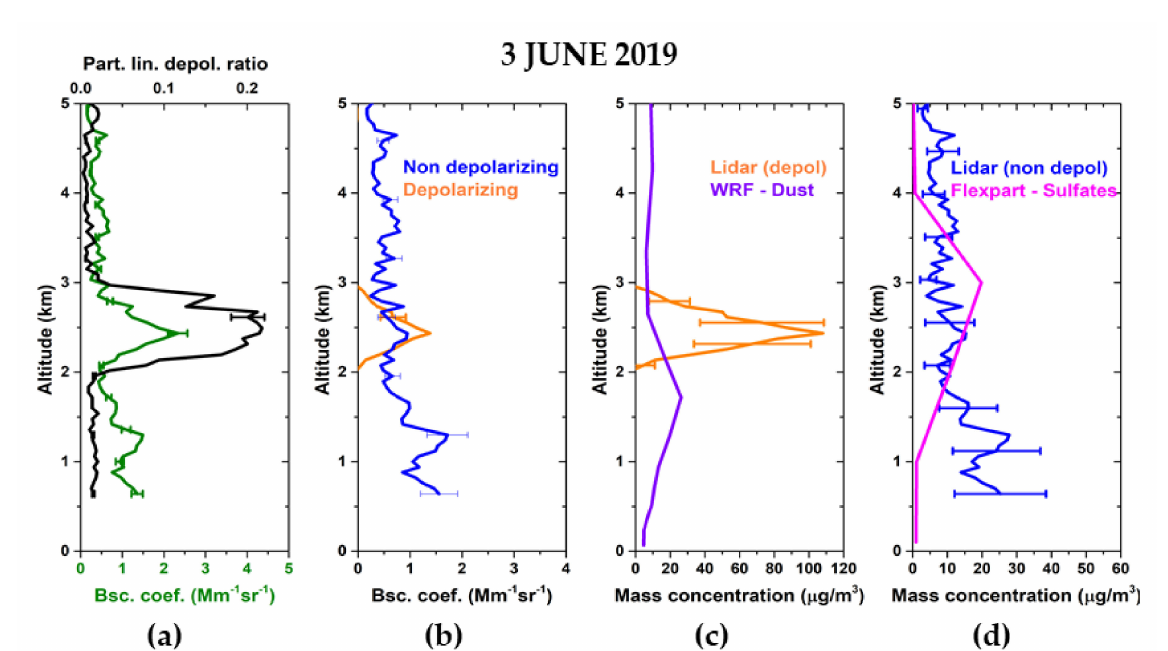
Figure 11. ( a ) Particle backscatter coefficient profiles (green line) and particle linear depolarization ratio (black line) at 532 nm, ( b ) non-depolarizing (sulfate/pollution) backscatter coefficient (blue line) and depolarizing (ash/dust) backscatter coefficient (orange line), ( c ) mass concentration profile of the depolarizing (Lidar depol—orange line) and WRF dust averaged concentration (purple line), and ( d ) mass concentration profile of the non-depolarizing (Lidar non-depol—blue line) component and sulfates averaged concentration (magenta line), at 00:00 to 02:00 UTC (in µ g/m 3 ) on 3 June